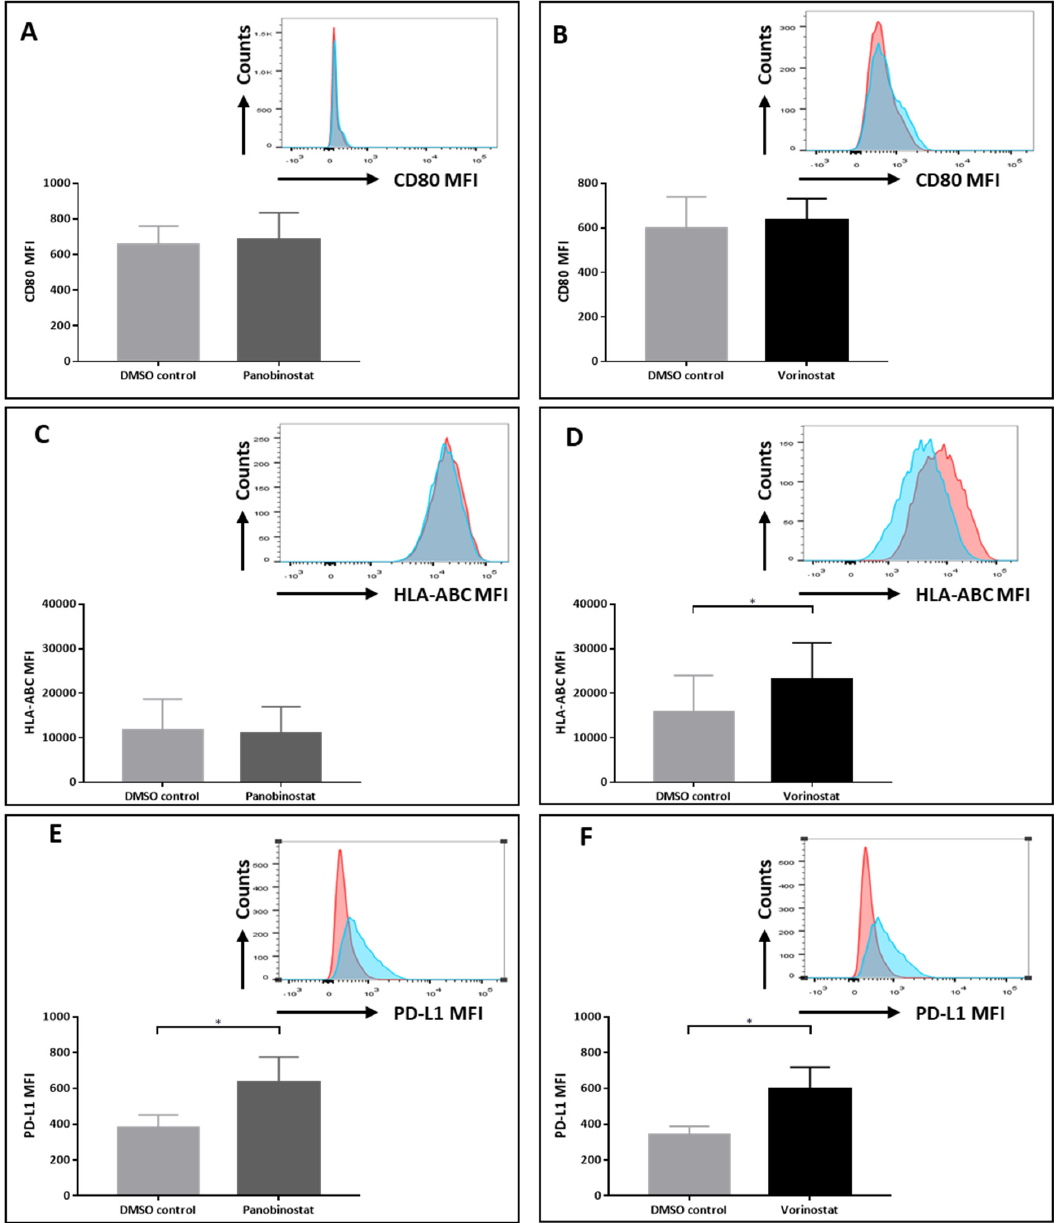
Figure 4. Alterations of surface markers on SW982 cells pretreated after HDACi for 48 h. The MFIs of CD80 ( A , B ), HLA-ABC ( C , D ) and PD-L1 ( E , F ) expression on panobinostat or vorinostat pretreated SW982 cells are displayed. DMSO served as solvent control. Histograms are showing representative flow cytometry results. Data analyzed contain at least four individual experiments with duplicates. Statistical significance was calculated using a paired two-way student t test. * p < 0.05.